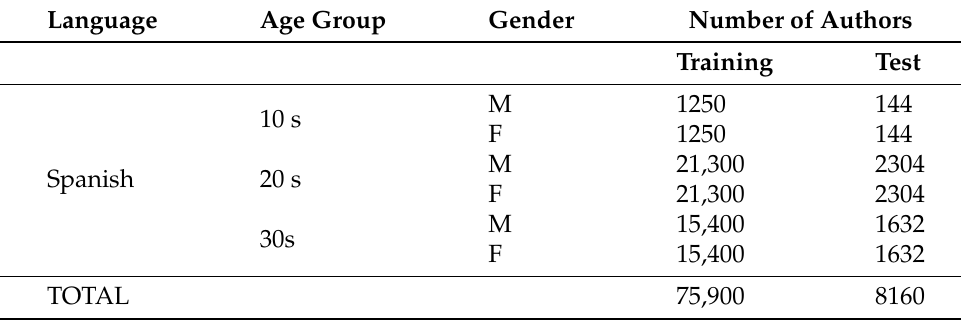
Table 2. PAN-AP-13 Spanish dataset